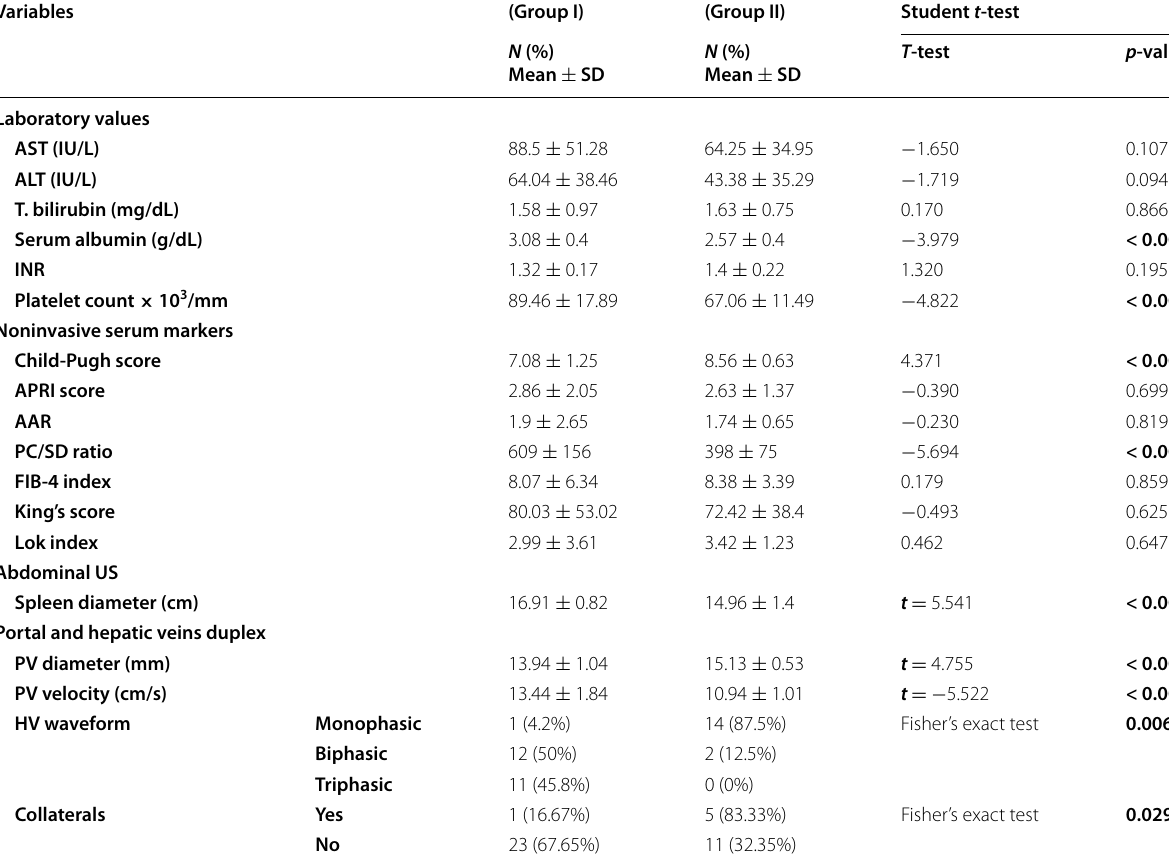
Table 5 Comparison between two subgroups of group A Variables